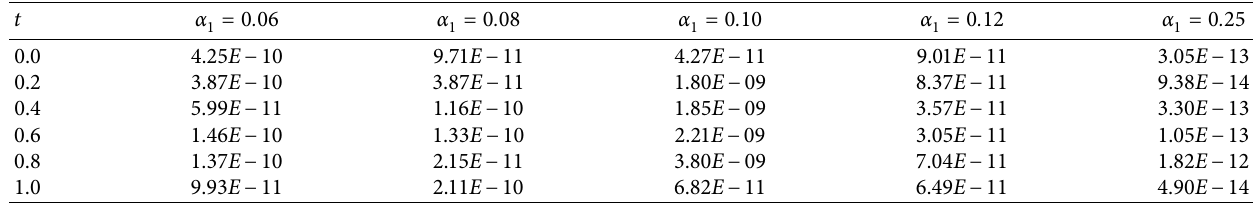
Table 6: Absolute errors obtained by the LeNN-WOA-NM algorithm for population density of local prey S ( t ) under the influence of the intrinsic growth rate of local prey α 1